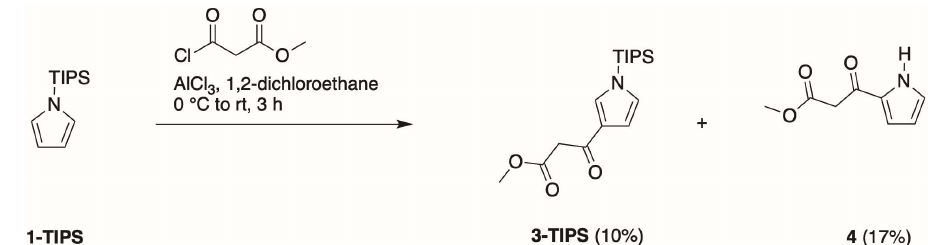
Scheme 5. Friedel–Craft acylation of 1-TIPS .